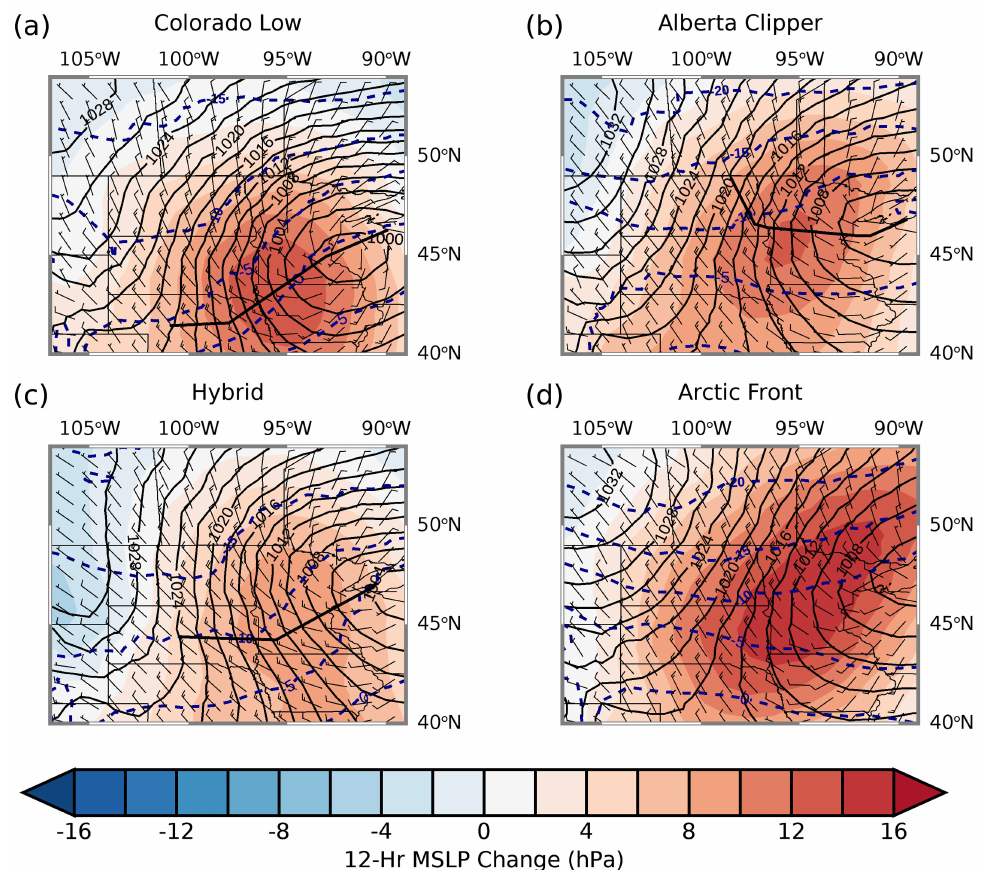
Figure 6. As in Figure 4, except for the midpoint of the blizzard. 12 hr MSLP change (12 hr post—midpoint) is provided by shaded